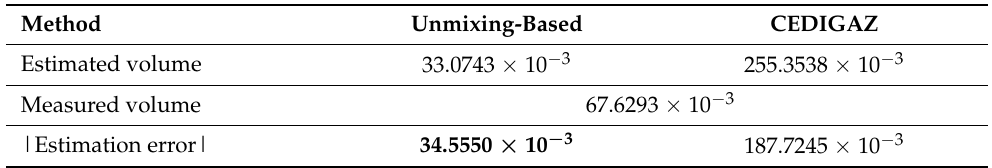
Table 6. Estimated annual 2021 flared gas volumes (in BCM) for the considered FIT-M8-101A-1U flare (the bold value represents the best estimation